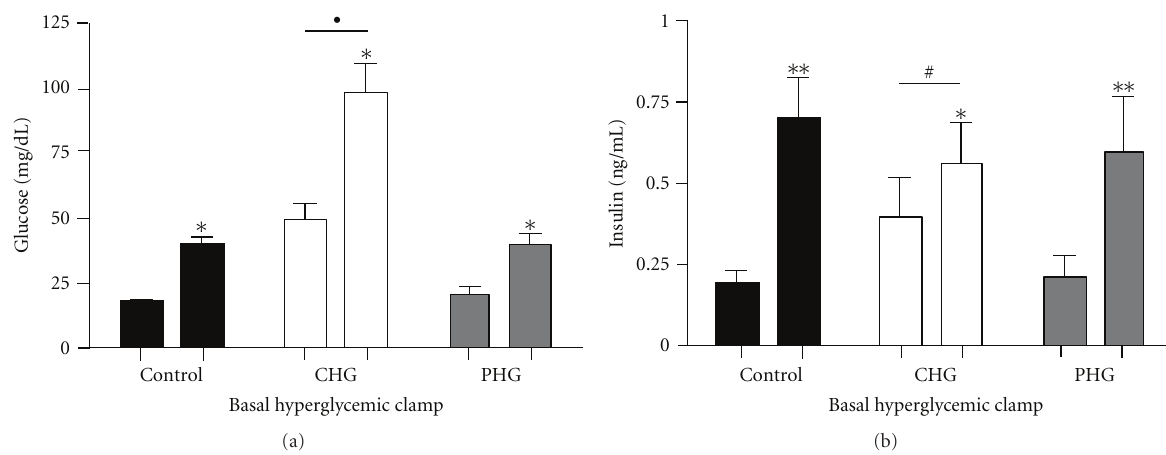
Figure 2: Fetal glucose-stimulated insulin secretion. A square-wave fetal hyperglycemic clamp was used to test insulin secretion. The average basal (minute − 25, − 15, − 5) and hyperglycemic clamp (minute 60, 90, 120) glucose (a) and insulin concentrations (b) in control ( n = 7, black bars), CHG ( n = 6, white bars), and PHG ( n = 5, gray bars) fetuses are shown. ∗ , ∗∗ indicate a significant di ff erence between basal and hyperglycemic clamp concentrations within a treatment group, P = 0 . 029, P < 0 . 0001, respectively. • indicates a significant increase in the incremental change of glucose concentrations in CHG compared to both PHG and controls, P < 0 . 0001. # indicates a significant decrease in the incremental change of insulin concentrations in CHG compared to both PHG and controls, P = 0 . 0002.